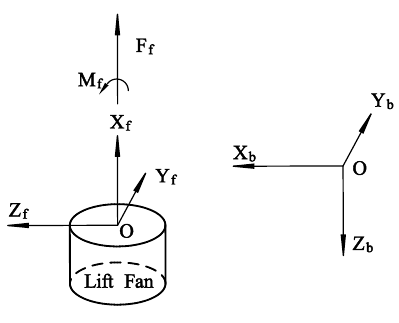
Figure 4. Lift fan force diagram.